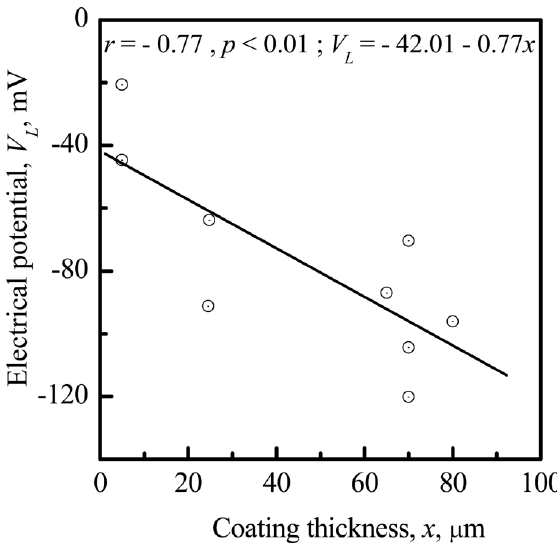
Figure 7. Correlation between the electrical potential (EP), V L , and the CP coating thickness, x.